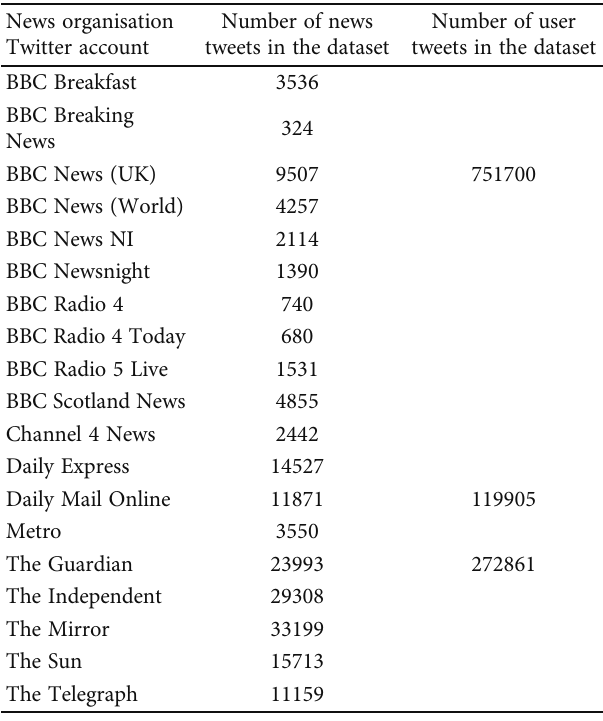
Table 1: UK news media